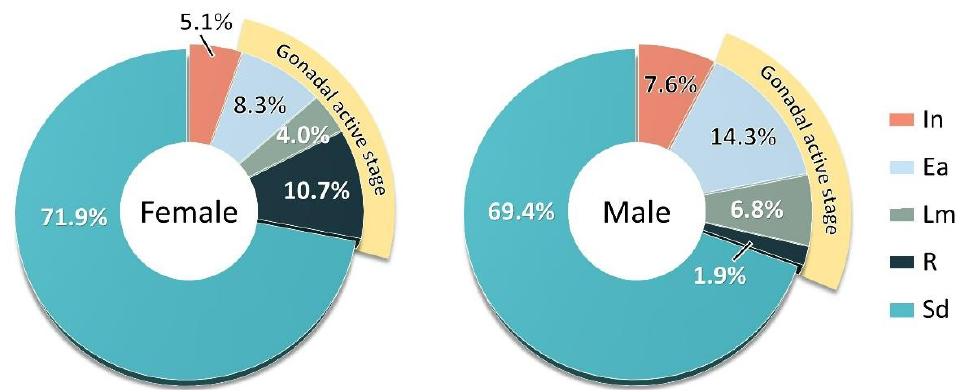
Figure 7. Annual frequency (August 2018–July 2019) of gonadal development stage in Buccinum osagawai . Ea: early active stage; In: inactive stage; Lm: late active and mature stage; R: ripe stage; Sd: spent and degenerative stage.